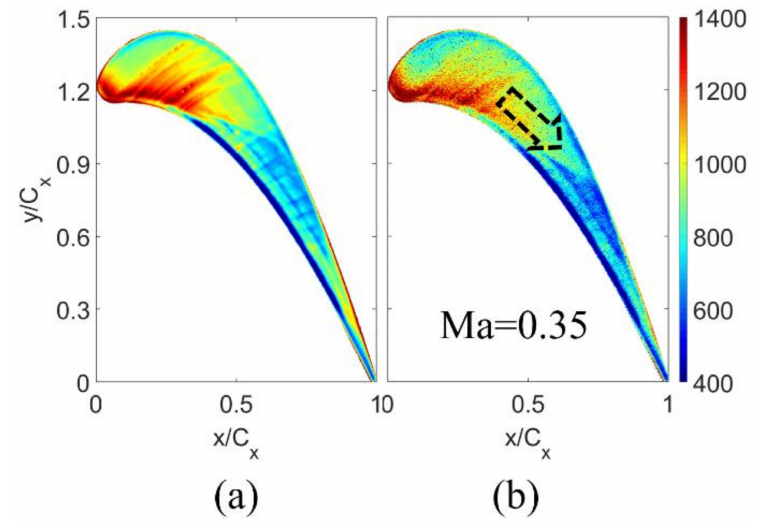
Figure 16. Heat transfer coefficient distribution of test blade tip for stationary and rotating conditions: ( a ) stationary; ( b ) rotating (Ma =